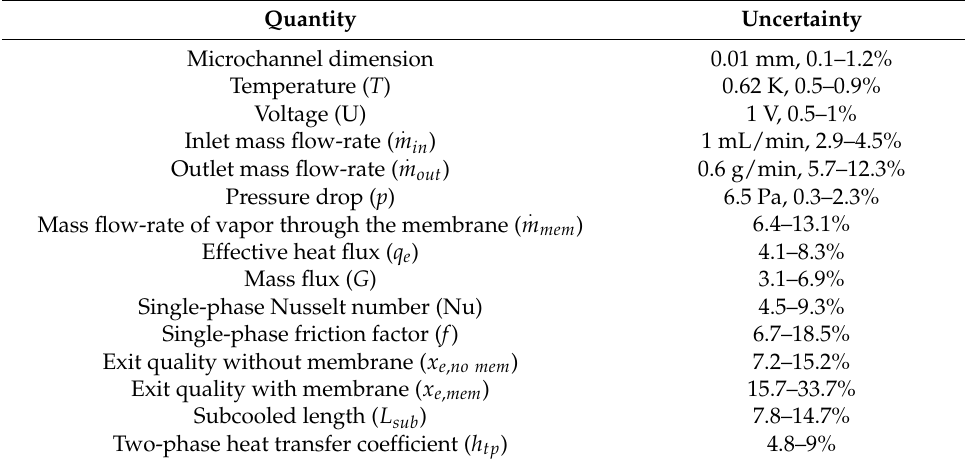
Table 2. Uncertainties of the measured and the derived